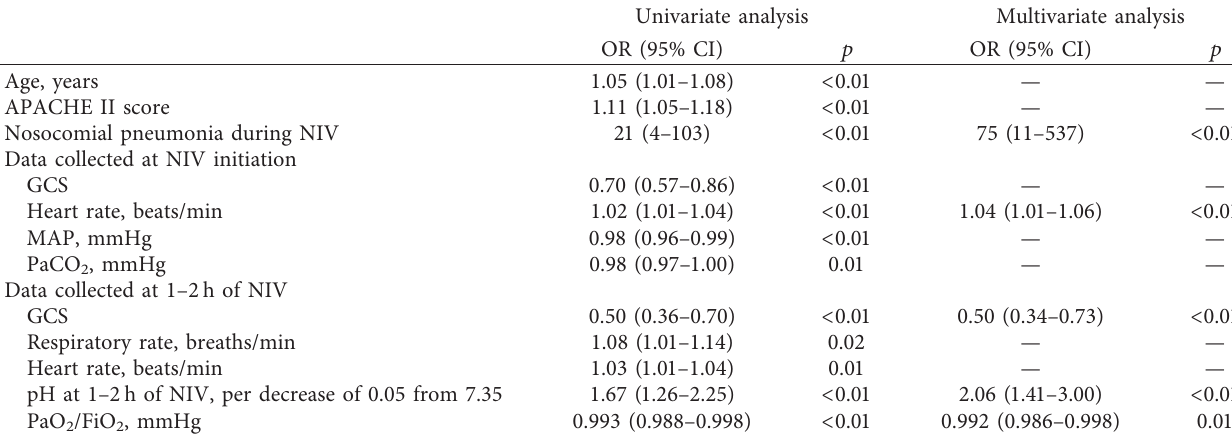
Table 2: Univariate and multivariate analysis of risk factors associated with late failure of